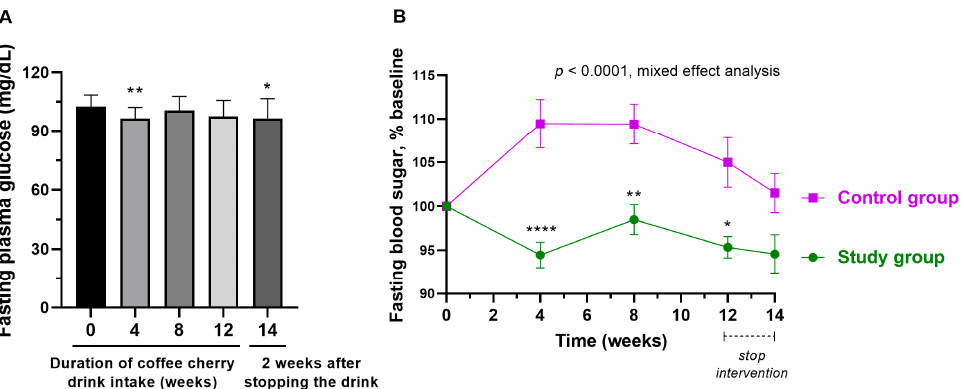
Figure 4. Changes in fasting plasma glucose of the volunteers. ( A ) The bar graph shows the mean and standard deviation of the volunteer’s fasting plasma glucose after the cherry coffee concentrate intake for 4, 8, and 12 weeks and 2 weeks after stopping intake (14 weeks), p -value analyzed by the Kruskal–Wallis test; ( B ) the line graph shows the mean and standard deviation of the volunteer’s